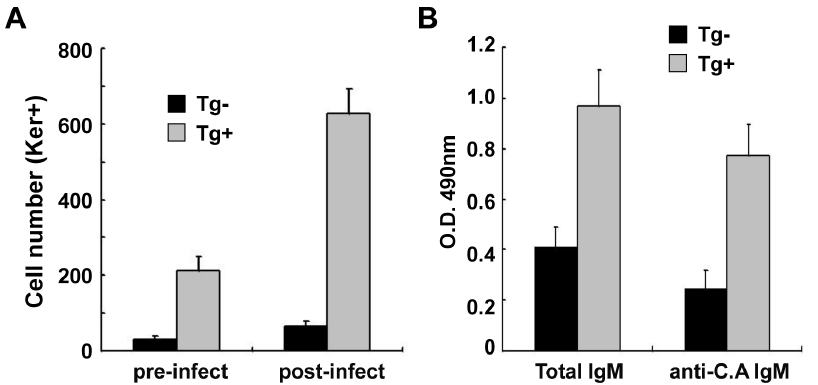
Figure 5. Analysis of C.albicans -specific B cells. (A) Cells collected from the PEC lavage before and after C. albicans inoculation were subjected to ELISPOT analysis using plate coated with mouse keratin. (B) Supernatant from the PEC B cells co-cultured with C. albicans were analyzed by ELISA to detect total IgM and C. albicans -specific IgM. Data shown are means 6 SD, n=6. * P , 0.01.